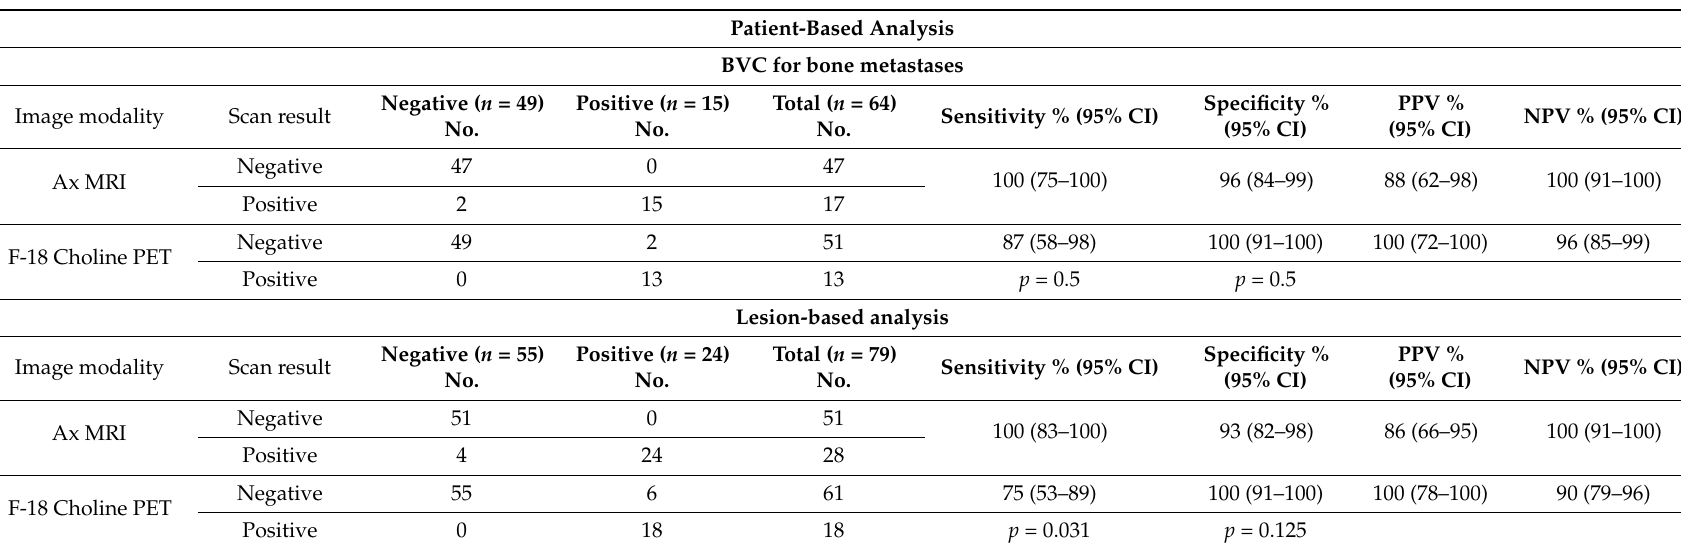
Table 1. Imaging results for predicting bone metastases on best value